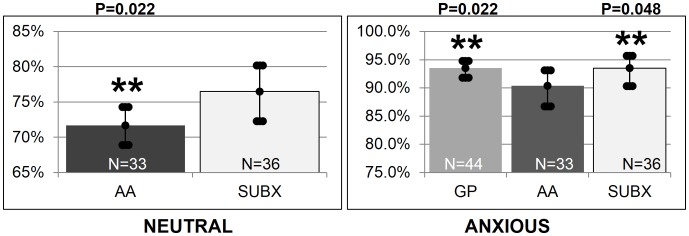
Significant differences in emotional empathy across groups.Interestingly, and as can be seen in Figure 11, the SUBX patients were more empathic to the neutral emotion state (76.5%; CI: 72.3–80.2) than AA members (p = 0.022) (71.7%; CI: 68.9–74.3). AA members were less empathic to anxiety (90.4%; CI: 86.7–93.1) than the GP (p = 0.022) (93.5%; CI: 91.8–94.8) and SUBX patients (p = 0.048) (93.5%; CI: 90.3–95.7).